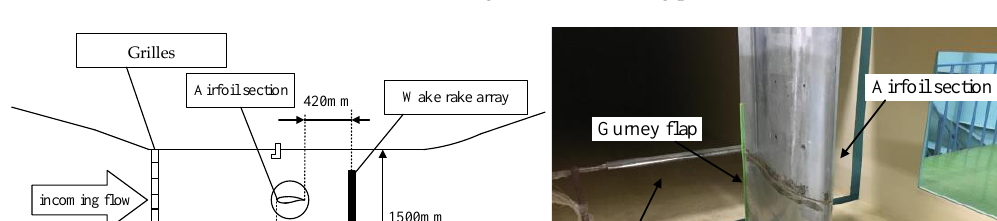
Figure 1. Schematic diagram of measuring position.